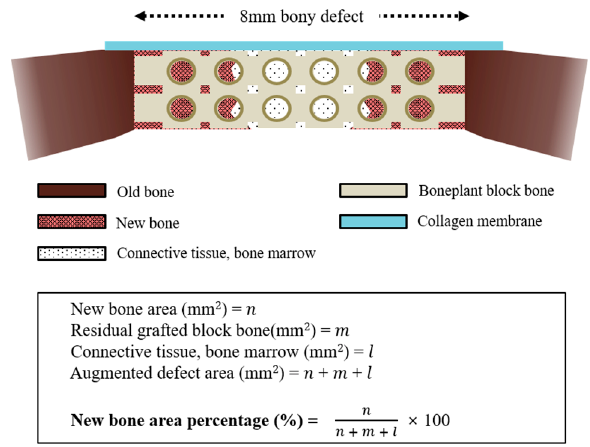
Figure 4. Schematic design for histometric analysis.